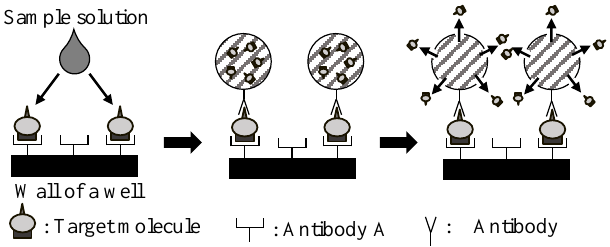
Figure 1. The conceptual principle underlying the direct signal amplification of the target molecules in the microcapsule-based amplification method.